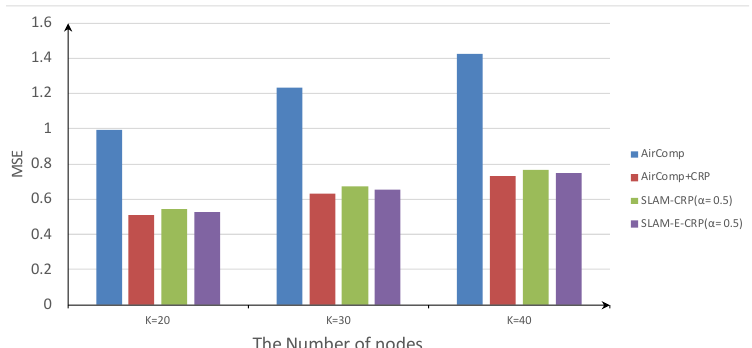
Figure 11. Average MSE of four methods.